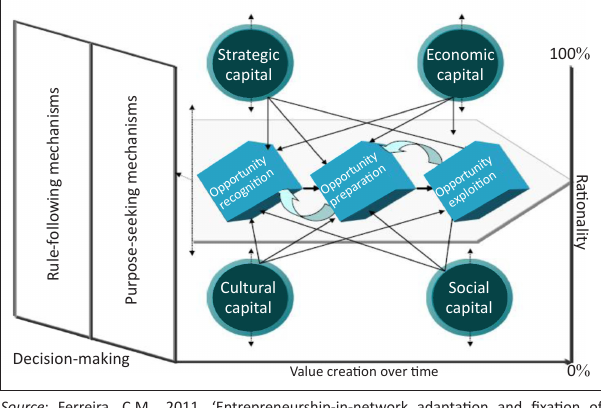
FIGURE 1: Adapted entrepreneurship-in-network